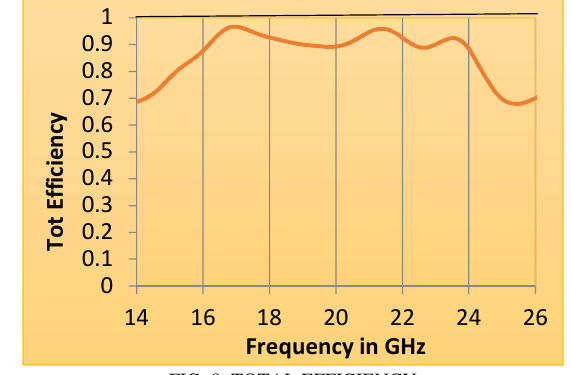
FIG. 8. TOTAL EFFICIENCY